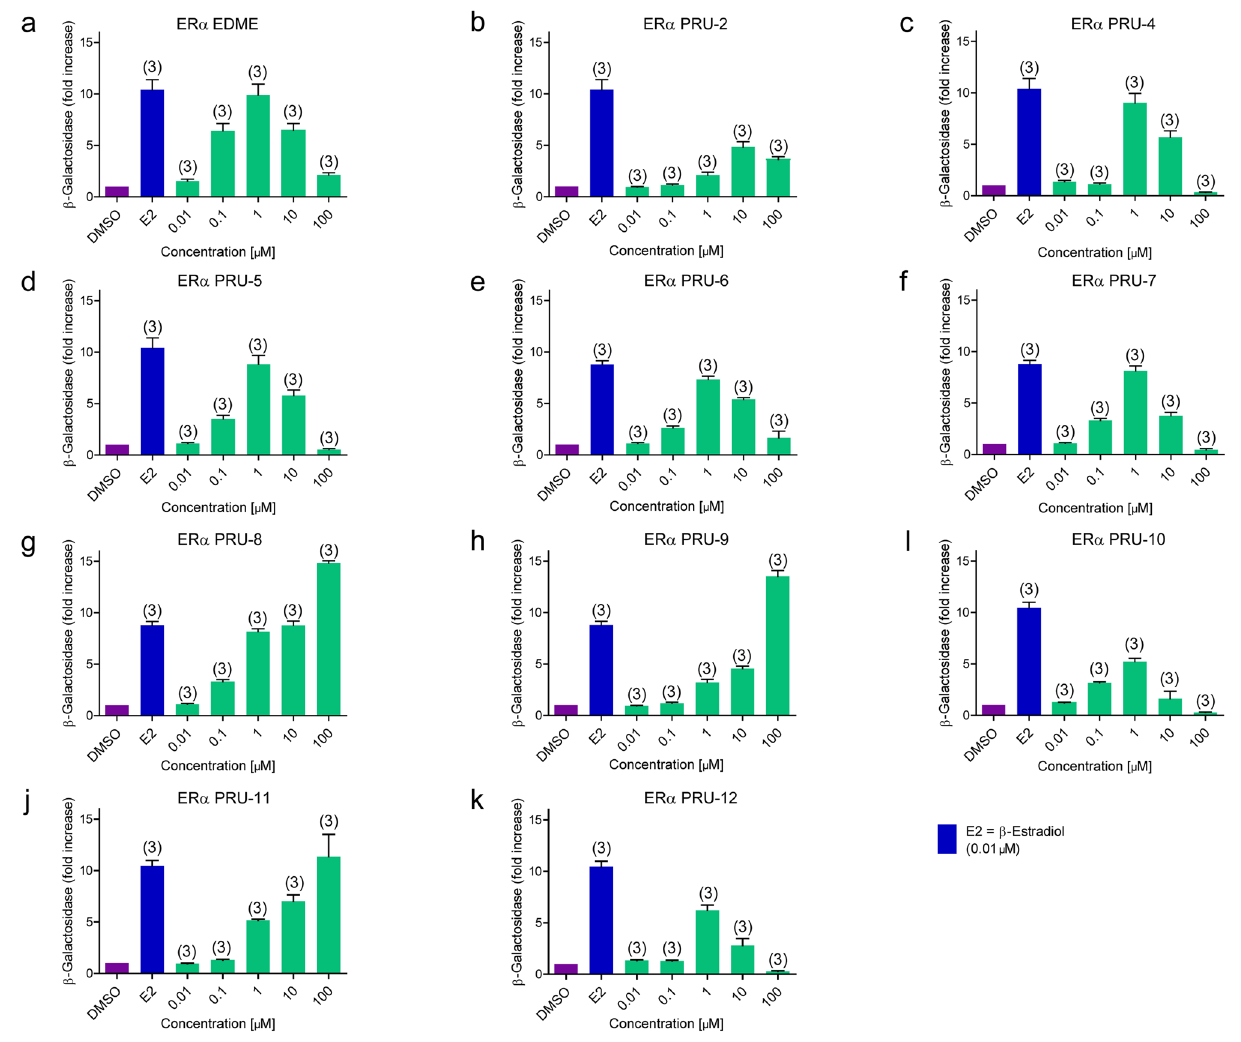
Figure 5. Activity at ERα of EDME and analogs. ( a – k ) Shown are effects of EDME and analogs at the estrogen receptor alpha (ERα) in Saccharomyces cerevisiae stably transfected with ERα, with the number of independent experiments in parentheses. The weakest effects at ERα were found for PRU-2, PRU-10, and